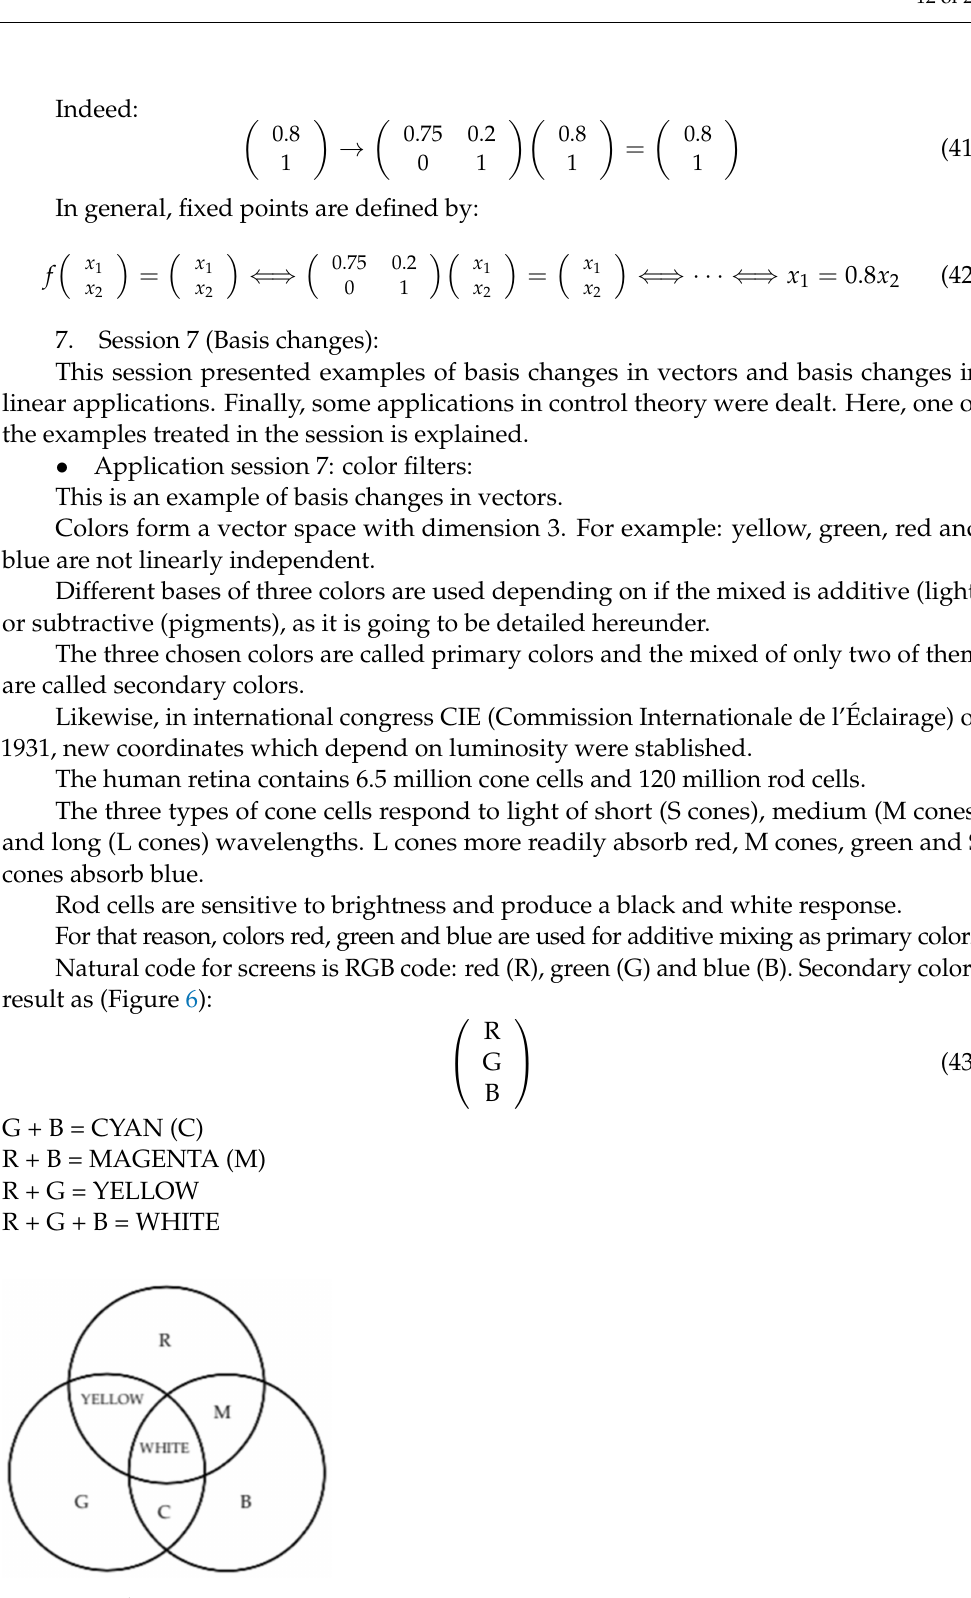
Figure 6. Colors. But black cannot be